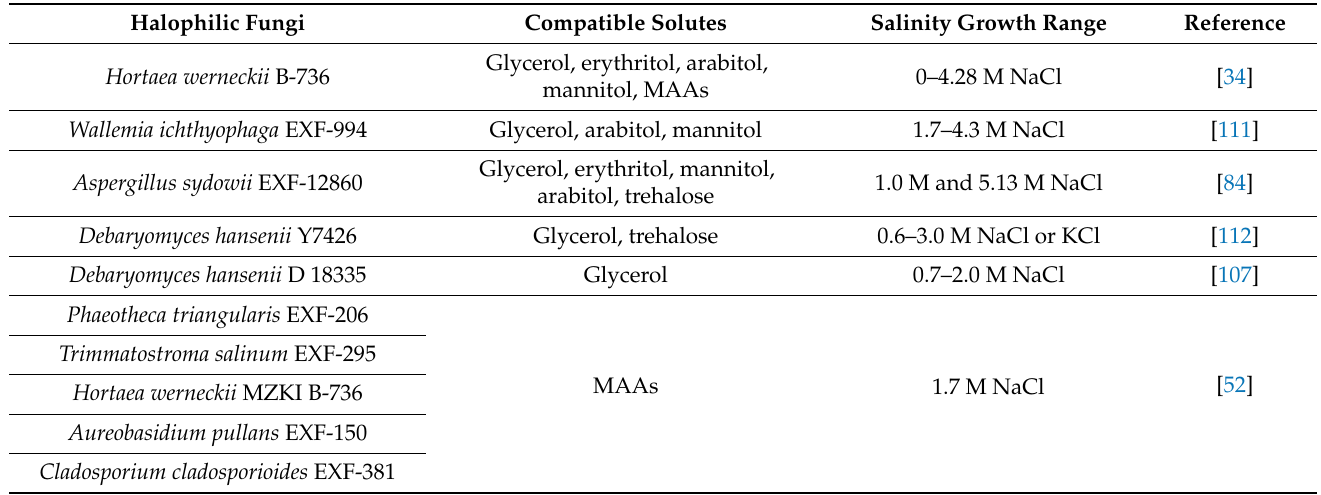
Table 4. Organic osmolytes from halophilic